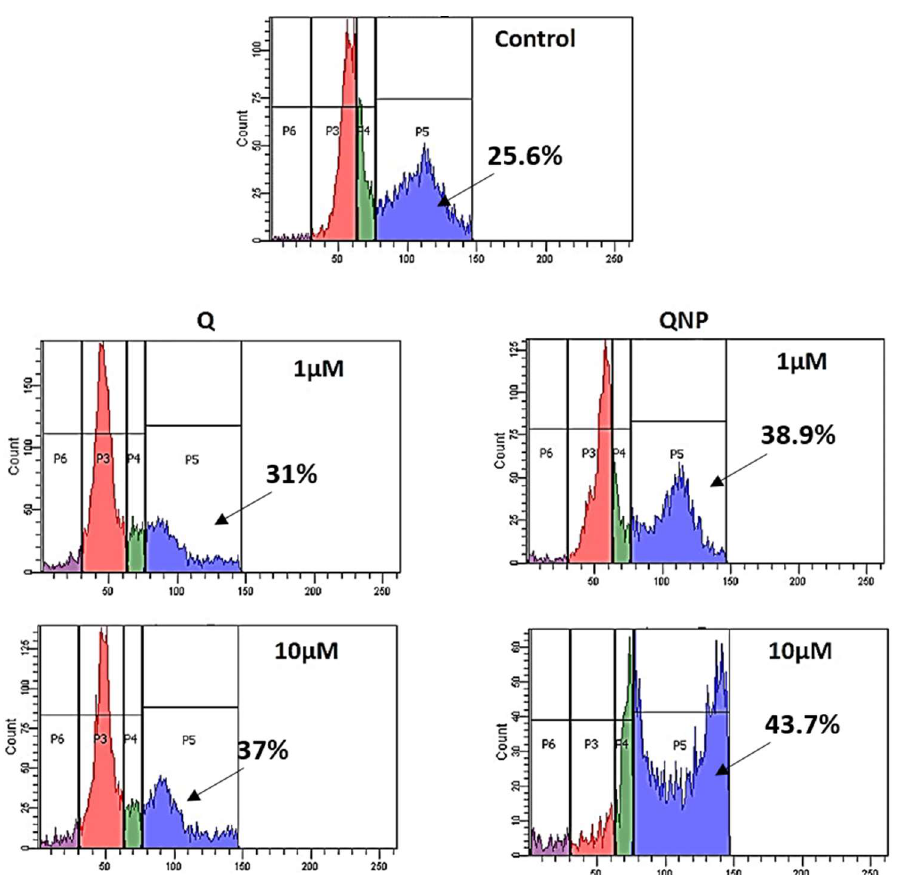
Figure 9. Cell cycle analysis of Q or QNP-treated HeLa cells. After Q or QNP treatment, cells were incubated in fresh medium for 2–6 h and analyzed through FACS. QNP (10 µM)-treated cells showed 43.7% G2 phase arrest.